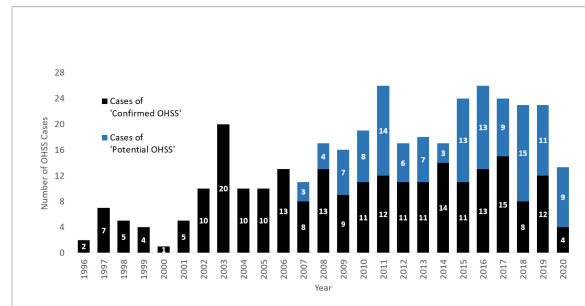
FIGURE 1 The absolute number of ‘ con fi rmed ’ and ‘ potential ’ OHSS cases from 1996-2020. The annual combined number of ‘ con fi rmed ’ and ‘ potential ’ OHSS cases between 1996 to September 2020. ‘ Potential OHSS ’ includes patients who presented to ICU with an OHSS-related condition and had a history of recent ART. All female patients were aged between 18-55 years presenting to an ICU in England, Wales, or Northern Ireland. OHSS cases for the year 2020 have been adjusted to account for the lack of data between October-December 2020. OHSS, Ovarian Hyperstimulation Syndrome; ICU, Intensive Care Unit; ART, Assisted Reproductive Technology.